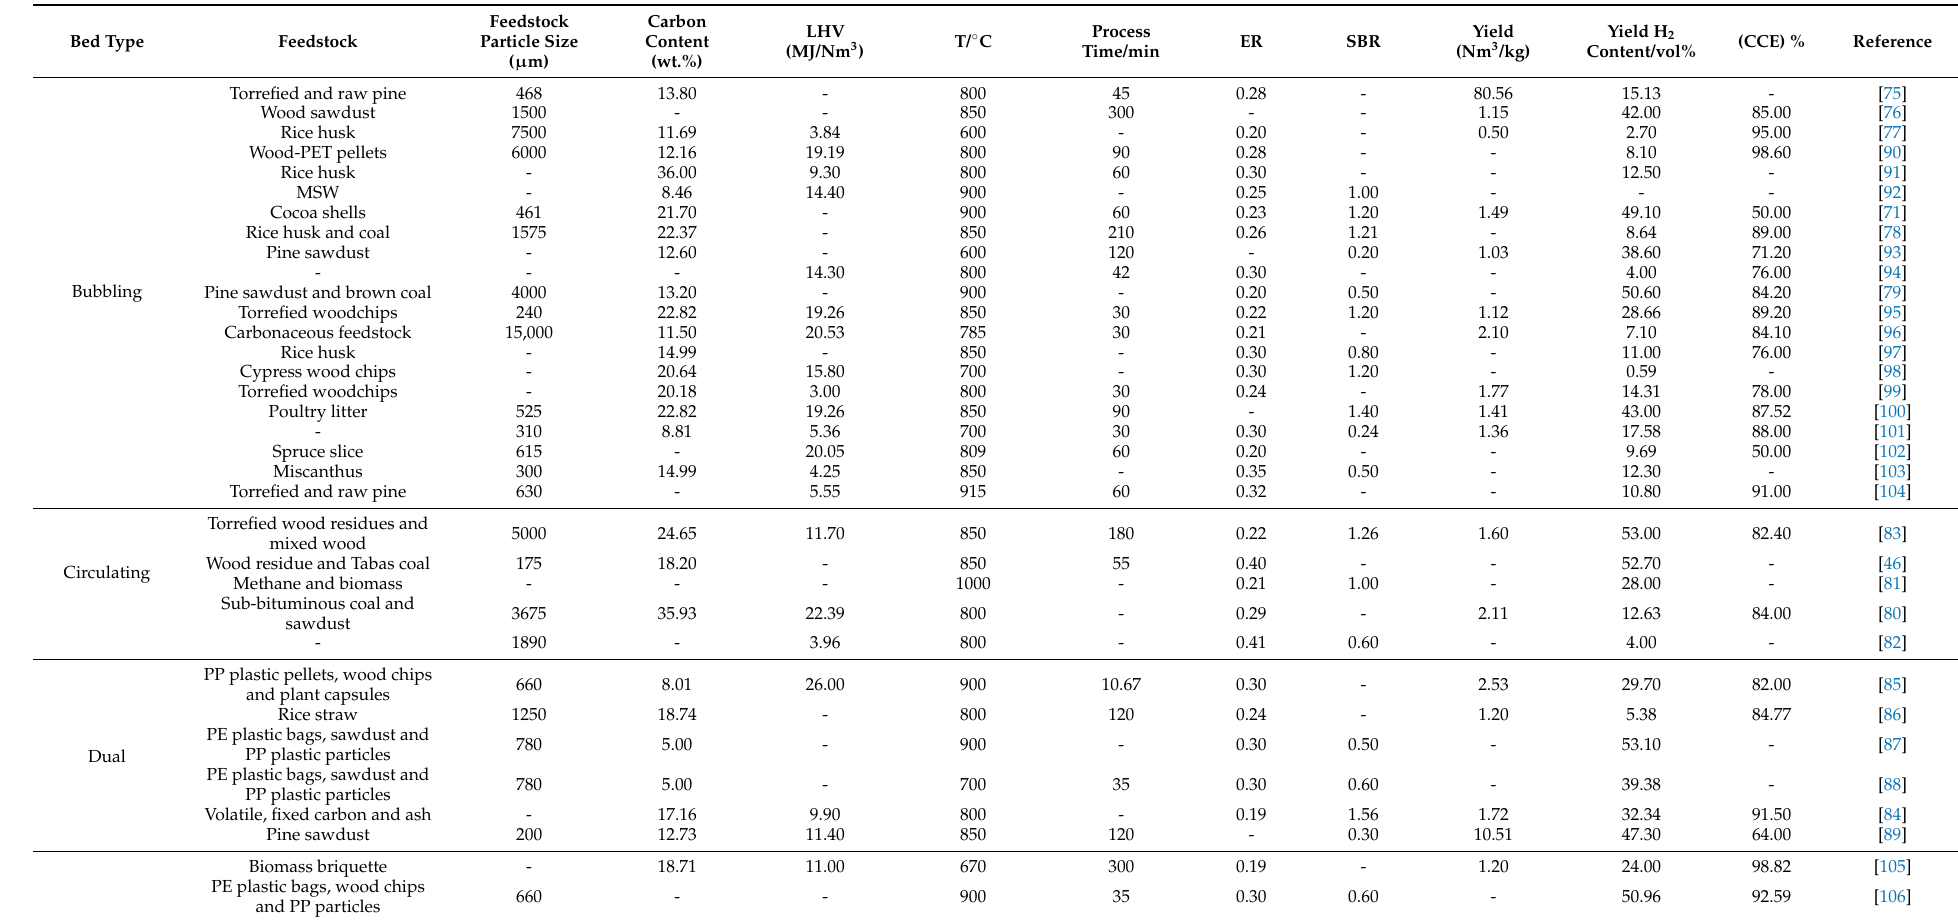
Table 3. Operational parameters versus corresponding hydrogen generation, where - represents the value that is not available from the literature (in this work, for easiness of data handling, the voids were replaced by the average reported